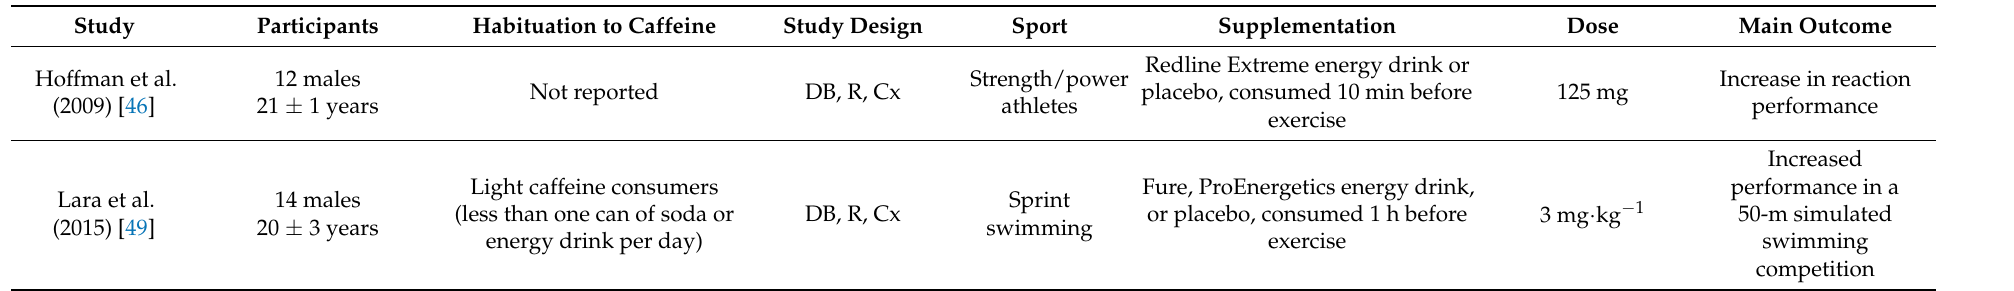
Table A2. Investigations in power-based sports